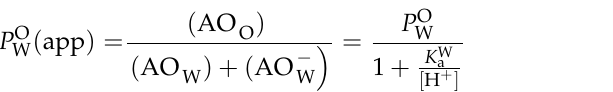
Table 6. Acidity constants for some phenolic acids for the carboxylic acid [pKa(1)] and that for the - OH group in the p -position [(pKa(2)].